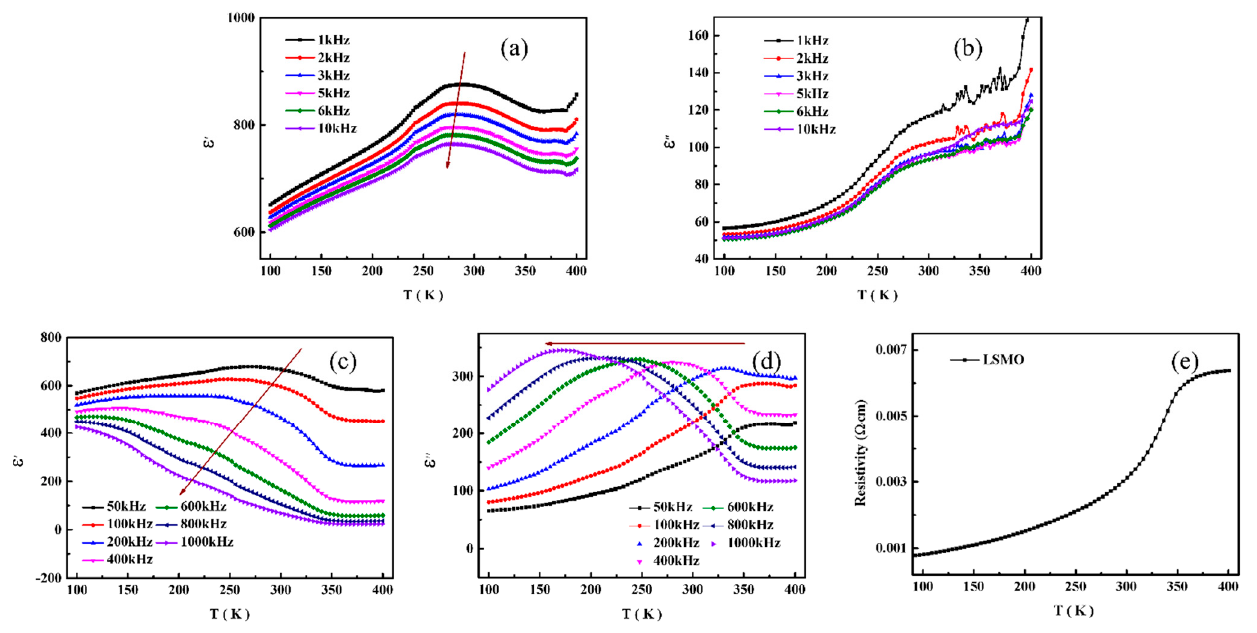
Figure 4. Temperature dependence of permiticity: ( a ) real and ( b ) imaginary parts at low frequencies; ( c ) real and ( d ) imaginary parts at high frequencies. ( e ) Temperature dependence of resistance of LSMO thin films.